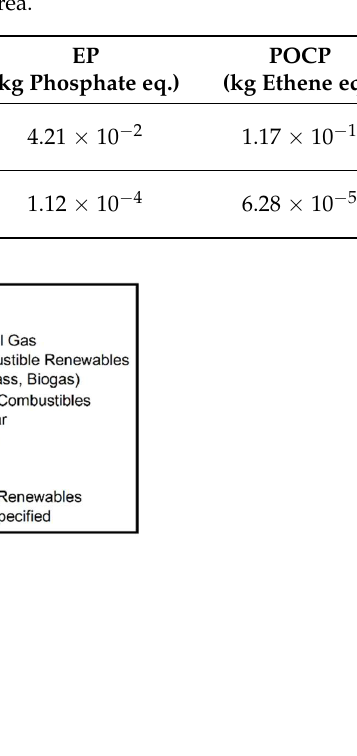
Figure 11. The proportion of resources used to generate national electricity in Korea. Based on Table 8, the daily environmental impact of each energy supply method for each ship from the viewpoint of the lifecycle is summarized in Table 9 below. Table 9. Daily emissions from each type of ship.